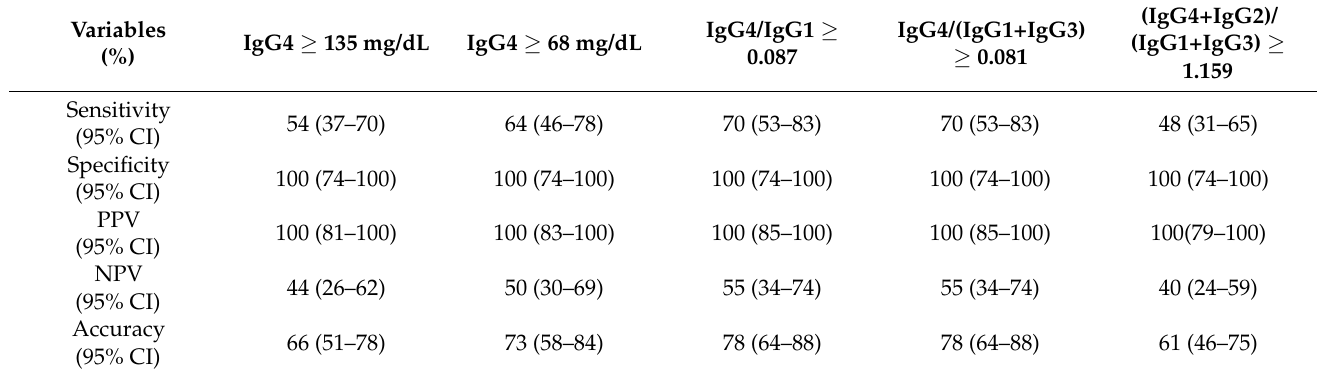
Table 2. Performance of the serum IgG subclass combinations for the differentiation of IgG4-SC from PSC.